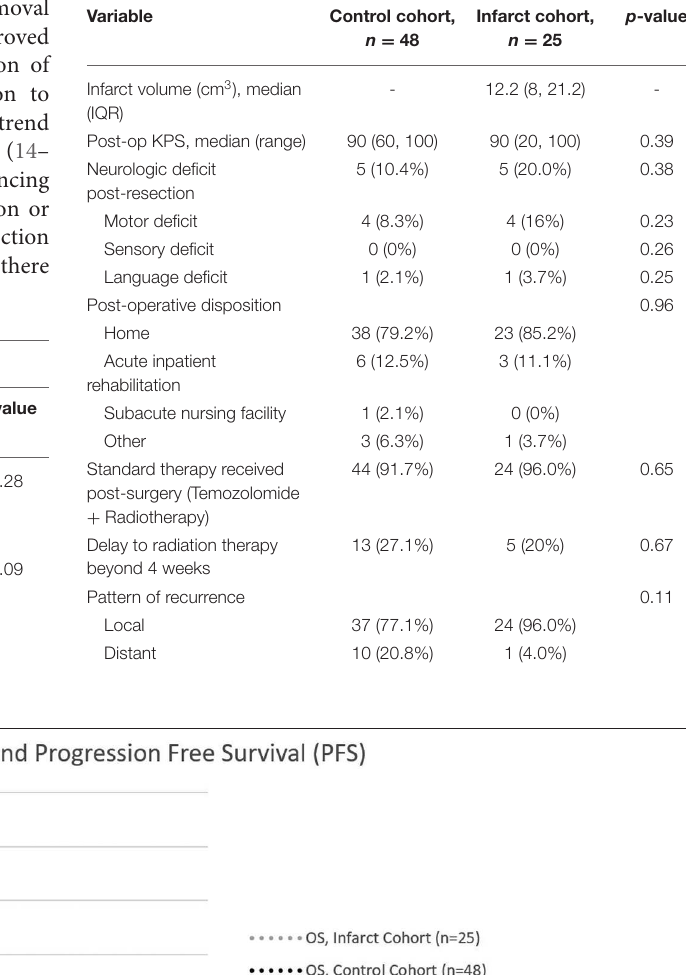
TABLE 4 | Outcome measures with univariate analysis.